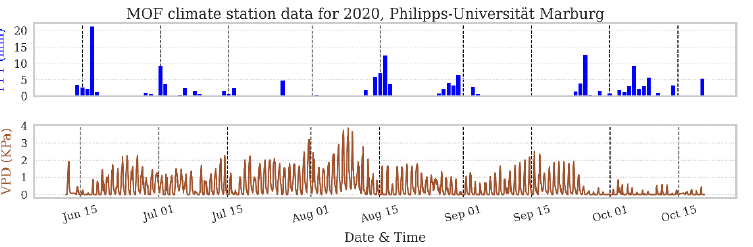
Figure 6. Precipitation (PPT (mm)) and vapor pressure deficit (VPD (kPa)) for 2020, based on data from the climate station in the Marburg Open Forest (MOF) study area.